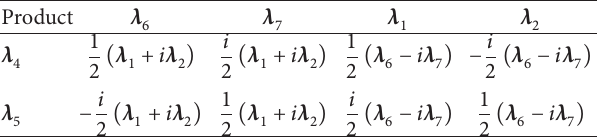
Table 6: Multiplication table of Gell-Mann matrices { 𝜆 4 , 𝜆 5 }{ 𝜆 6 , 𝜆 7 , , 𝜆 } (left times top). 𝜆 1 2